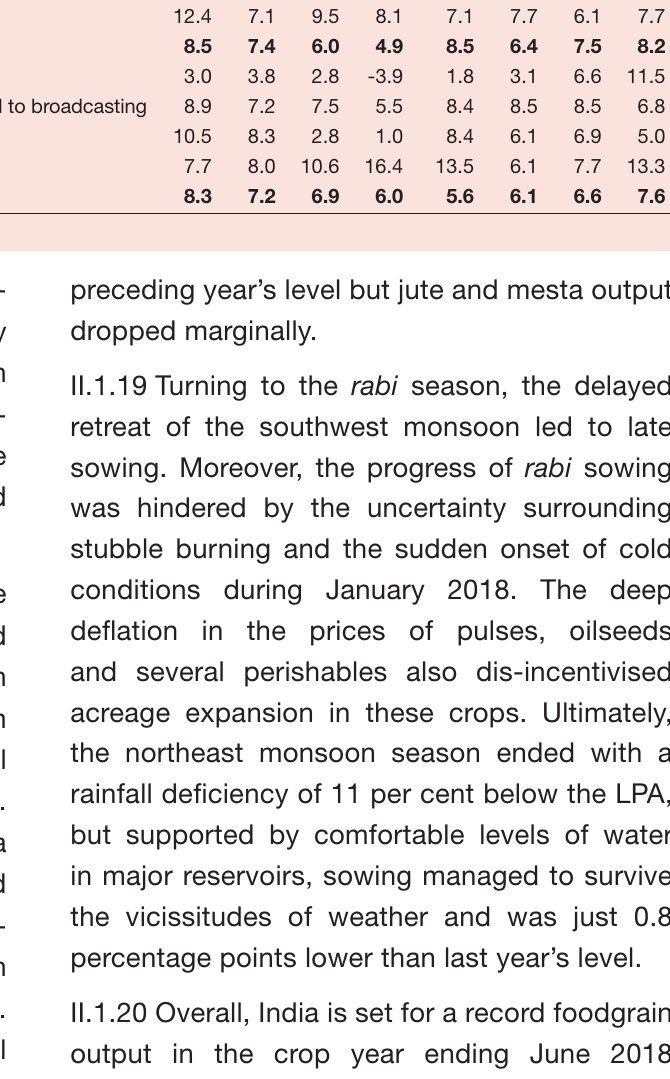
Table II.1.2: Real GVa Growth (2011-12 Prices)